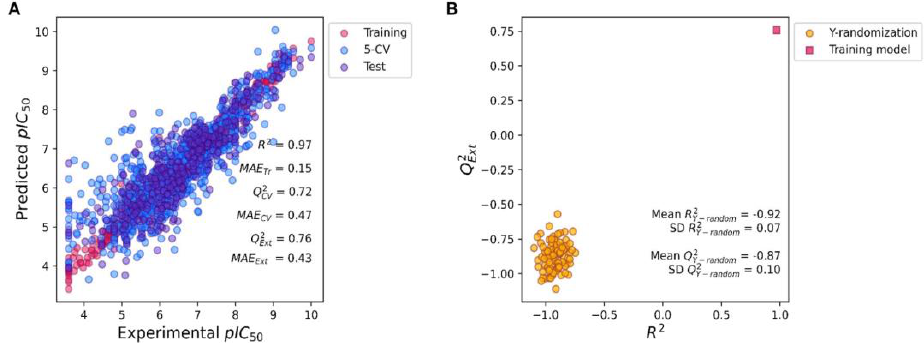
Figure 3. Regression model for predicting pIC 50 values against KRAS G2C . ( A ) Regression XGBoost model. The red, blue, and purple circles indicate the training dataset, 5-fold cross-validation (5-CV), and test datasets, respectively. ( B ) The Y-randomization analysis of the regression model. The yellow circles and red squares represent the Y-randomization models ( n = 100) and the original model, respectively.